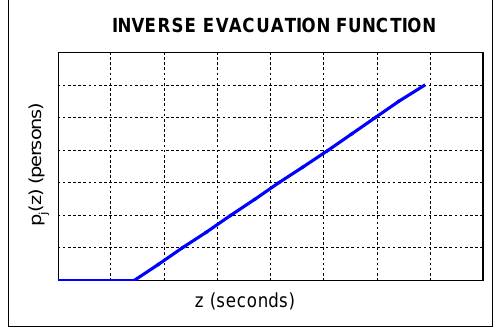
Figure 4. “Inverse evacuation